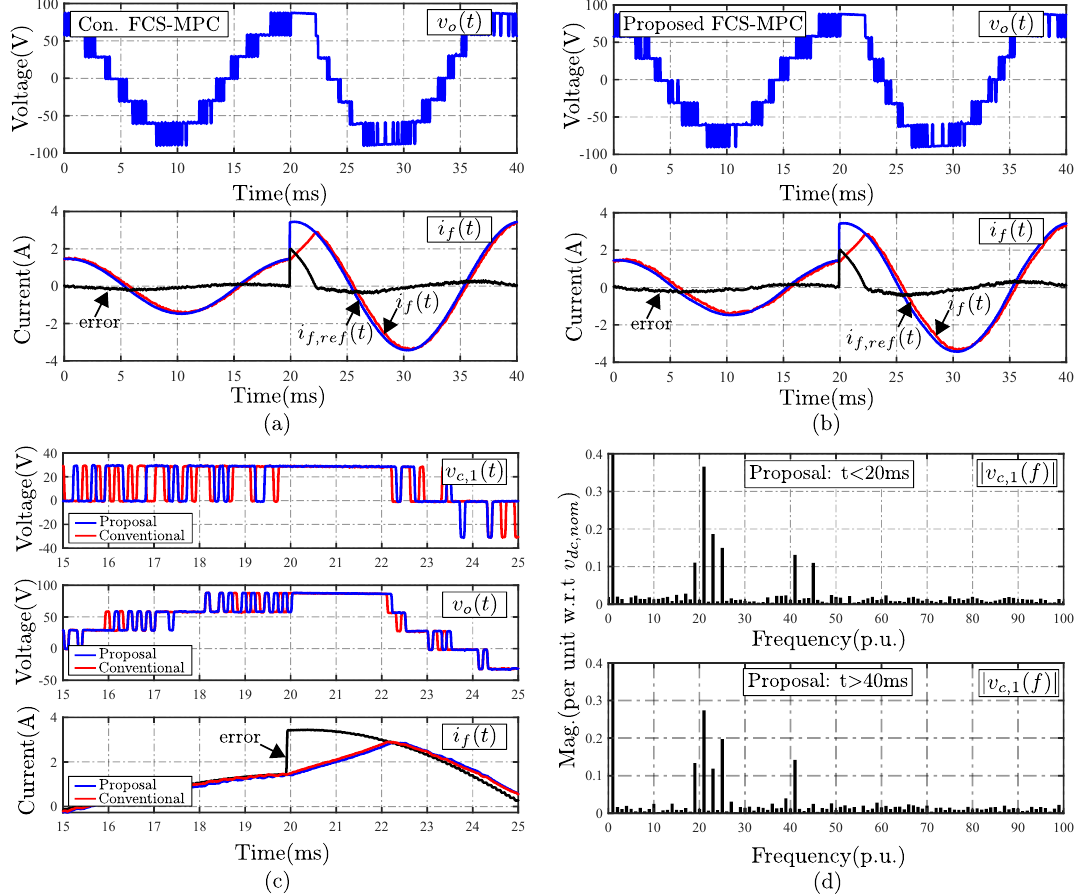
Figure 9. Experimental results for a current reference step-change from 1.5 A to 3.5 A. ( a ) conventional FCS-MPC [24]; ( b ) proposed FCS-MPC; ( c ) voltage states (zoom); ( d ) cell 1 voltage spectrum, before and after the change.